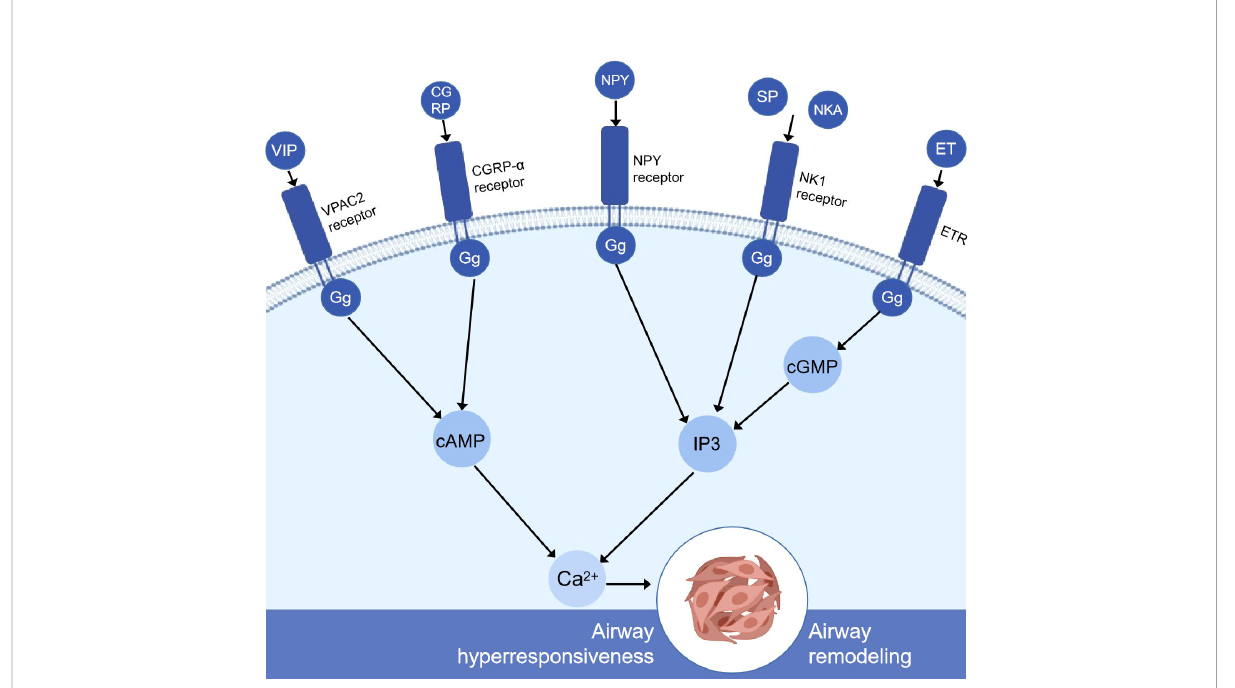
FIGURE 1 Simpli fi ed schematic diagram of the molecular mechanism of pulmonary neuroendocrine cell secretion-mediating airway remodeling and airway hyperresponsiveness. VIP, CGRP, and G protein-coupled receptors increase cAMP through adenylyl cyclase (not shown). Then, cAMP increased intracellular calcium through protein kinase A (not shown). NPY, SP, NKA, and G protein-coupled receptors altogether cause the breakdown of inositol 1,4,5-phosphate (IP3) and the subsequent release of calcium ions from intracellular storage. ET is produced by the stimulation of protein kinase C (not shown), binds to other receptors in lung tissue, such as the endothelin receptor, activates cyclic GMP, secondary to increased IP3 levels, and releases the calcium ions stored in the cells. High levels of calcium can severely affect airway smooth muscle cells, airway epithelial cells, and goblet cells and ultimately lead to airway remodeling and airway hyperresponsiveness. VIP, vasoactive intestinal peptide; CGRP, calcitonin gene-related peptide; NPY, neuropeptide Y; SP, substance P; NkA, neurokinin A; ET, endothelin; ETR, endothelin receptor; VPAC2, vasoactive intestinal peptide receptor 2; IP3, inositol 1,4,5-triphosphate; cAMP, cyclic adenosine monophosphate; cGMP, cyclic guanosine